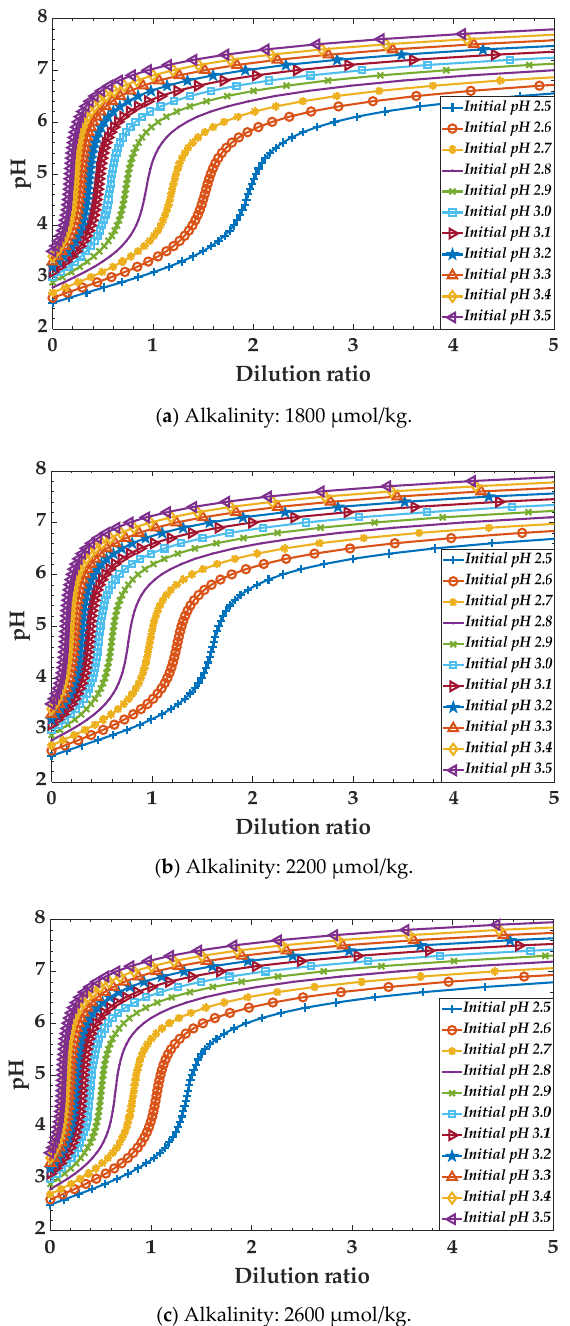
Figure 3. Titration curves obtained by the theoretical chemical reaction model. Table 1. Required dilution ratio and volume fraction depending on the initial pH of scrubber wash water under different seawater alkalinity values.